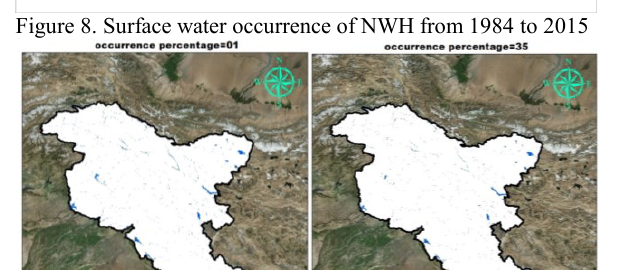
Figure 6. SCA during 2016-2017 season ( a) November 25– December 02 2016, (b) January 09–16, 2017, (c) February 10–